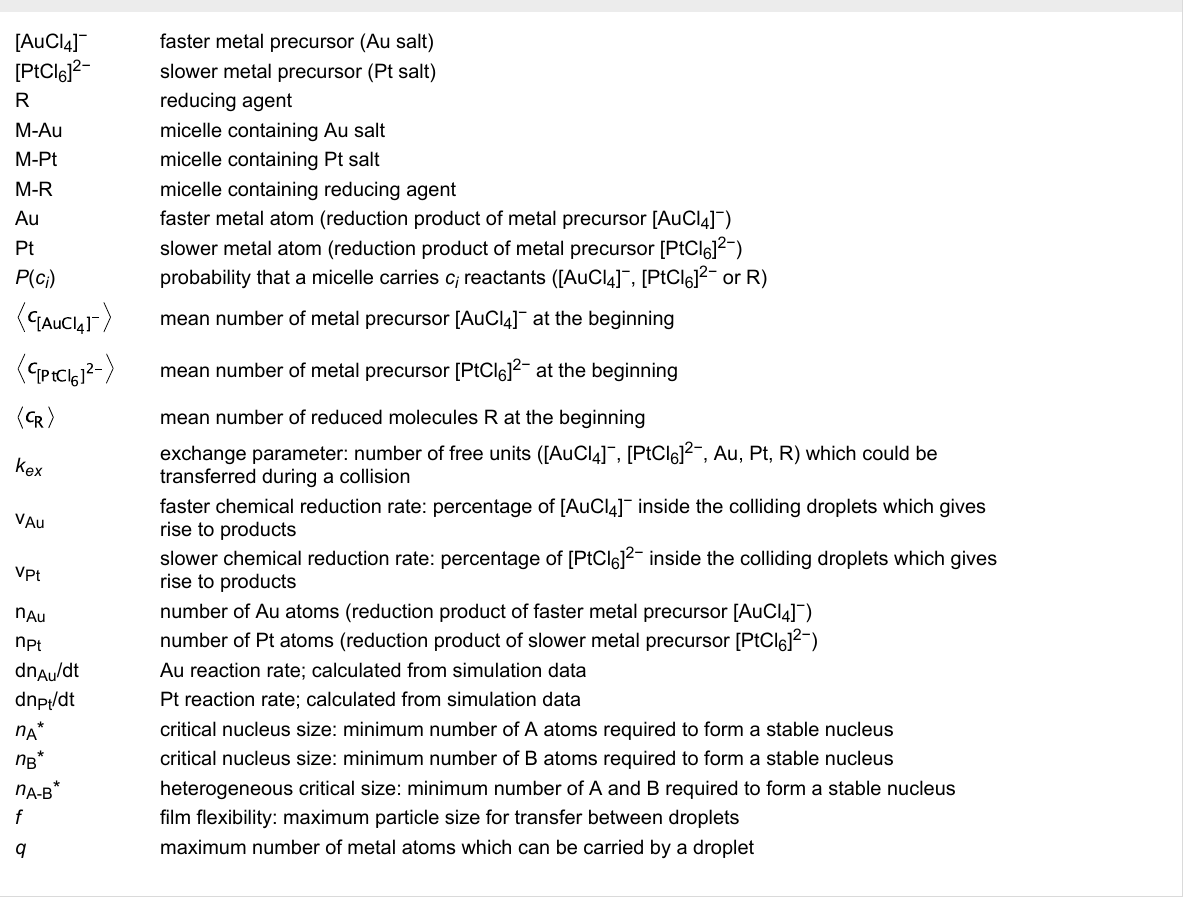
Table 1: Glossary of acronyms and abbreviations used in this article. [AuCl 4 ]